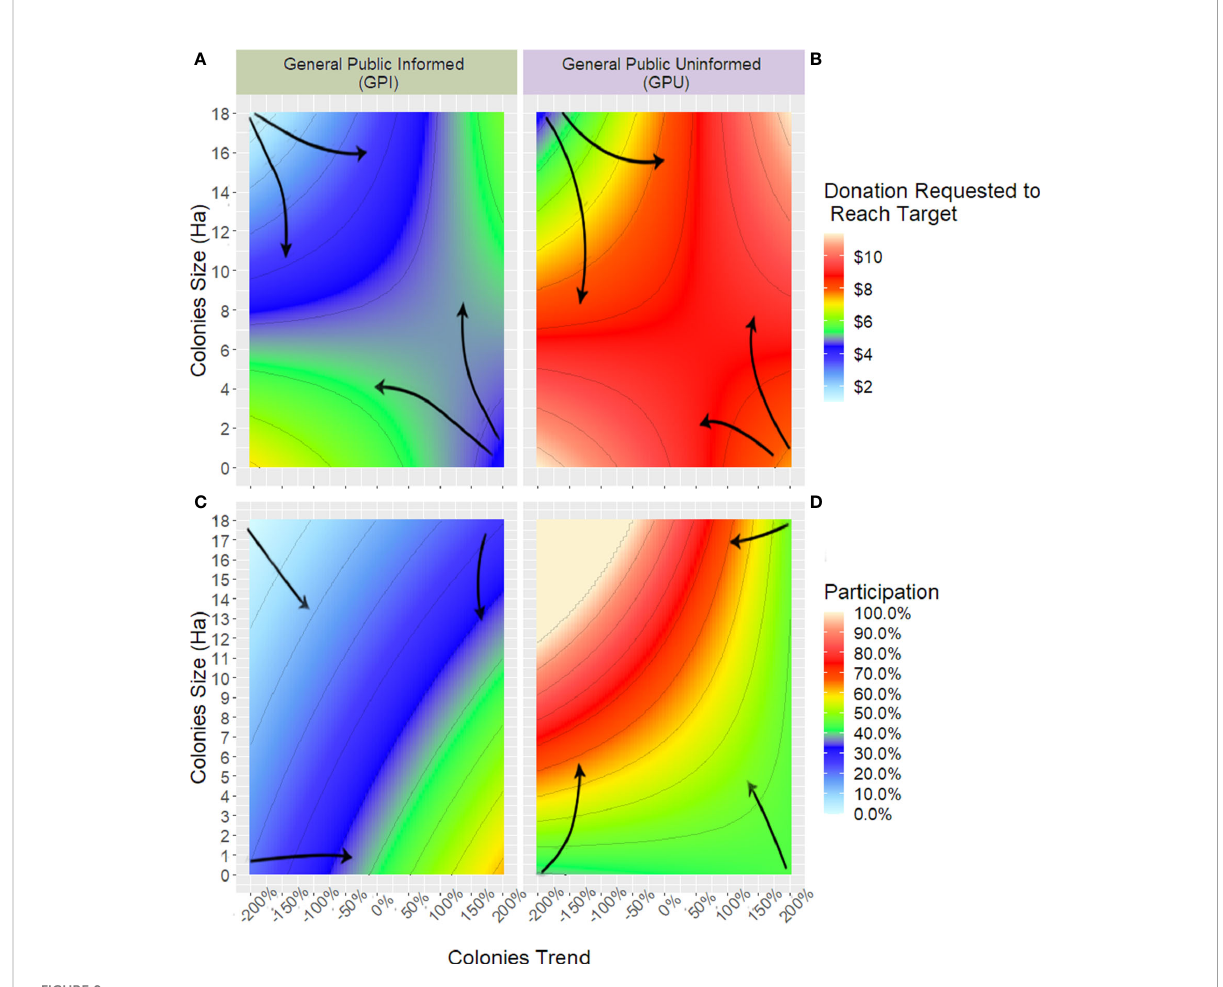
FIGURE 9 Heatmap of linear regression describing optimal donations request (upper panels) and market share (lower panels) as a relation of the current area of the overwintering colonies and their trend over time for both models used, General Public Informed (left panels) and General Public Uninformed (right panels). Arrows indicate the gradient ’ s general ascending